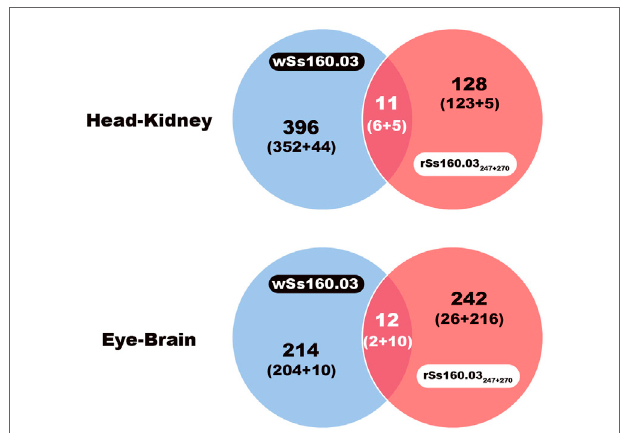
FigUre 1 | Venn diagram of DEGs using edgeR. Common and different DEGs detected after infection with the wild-type and mutant reassortants in head kidney and nervous tissue. Number of DEGs: upregulated +